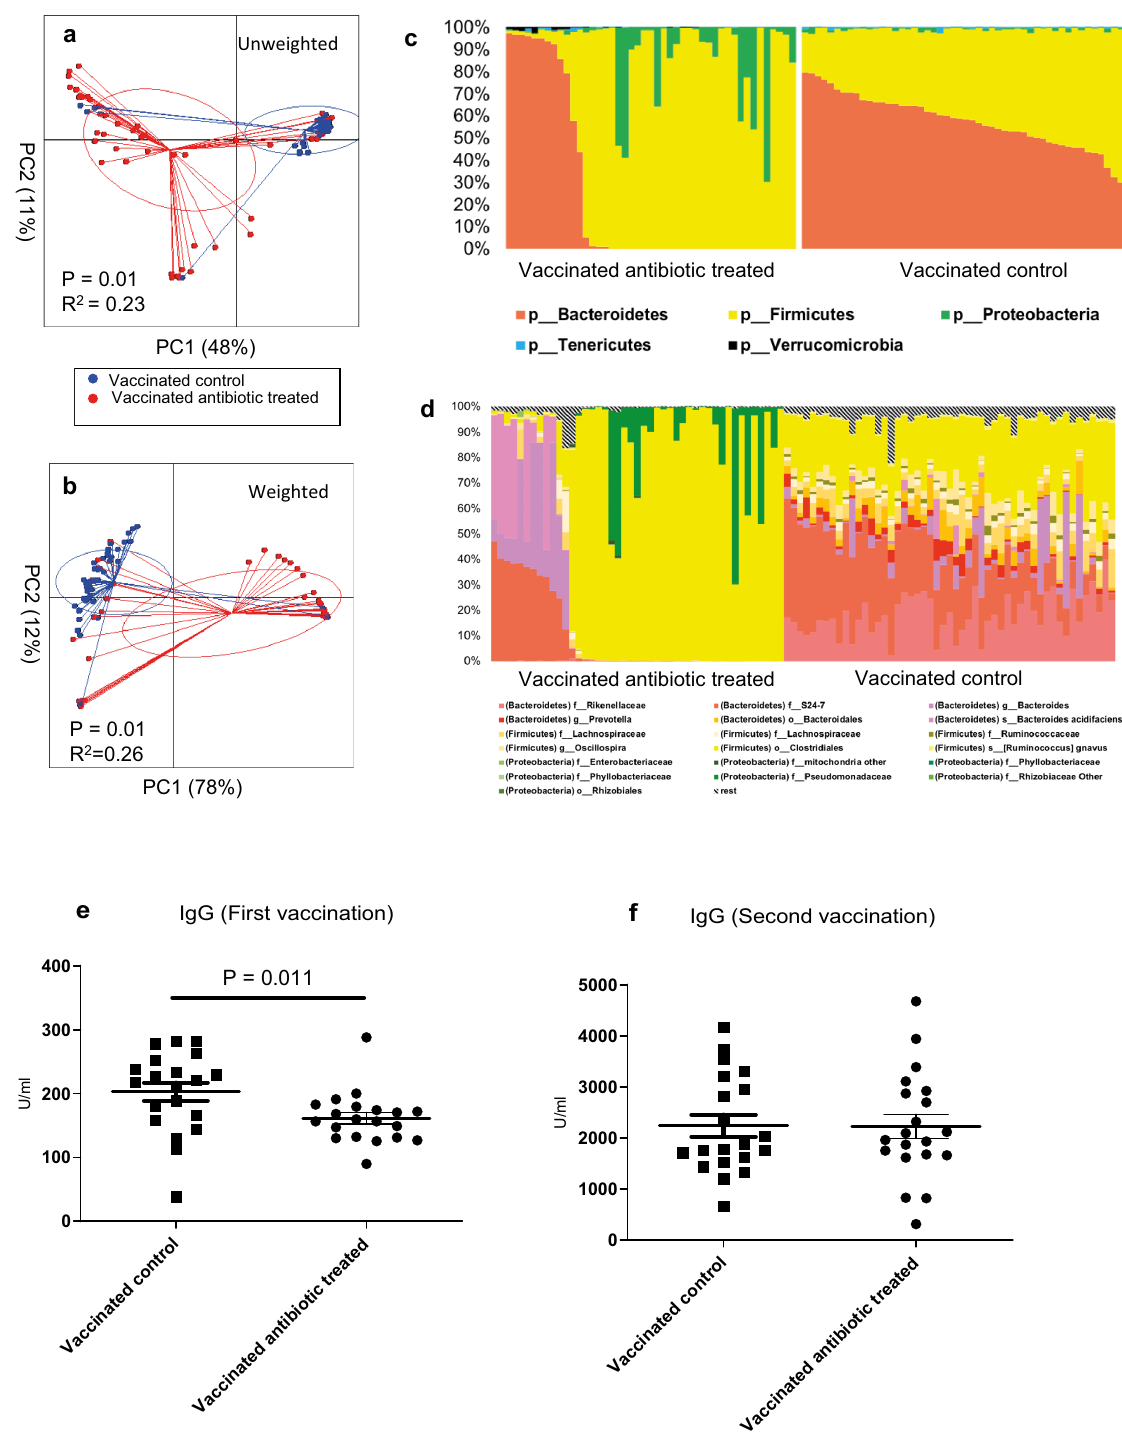
Fig 3. The impact of a antibiotics on gut microbiota and IgG response to tetanus vaccination. BALB/cBomTac mice were vaccinated twice with a tetanus vaccine, either in combination with antibiotics (ampicillin) in the drinking water (1g/L) or with pure drinking water. Unweighted (a) and weighted (b) PCoA plots with PERMANOVA results, relative abundance bar plots on phylum (c) and OTU (d) level after microbiota characterization on feces sampled three weeks after second vaccination, and anti-tetanus IgG (median) two weeks after first (e) and three weeks after second (f) tetanus